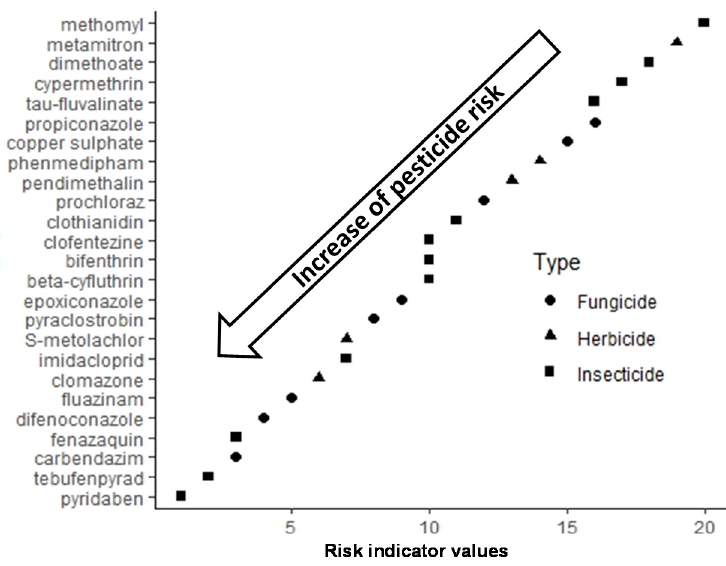
Figure 13. Rating of the pesticide risk indicators for earthworms.